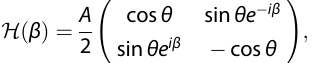
Fig. 2 Direct measurement of the QFI. a The pulse sequence for the measurement of the QFI using the NV center spin. The NV center spin is fi rst polarized in the state 0 j i by applying a green (532 nm) laser pulse and the θ -dependent resource state ψ subsequent microwave pulse Y θ . The interrogation (i.e., the free evolution) for time T results in the parameter-dependent fi nal state ψ θ ð β Þj i . The parametric modulation via the amplitude and phase-modulated microwave driving is described by the Hamiltonian H [ β ( t )] with β ð t Þ ¼ β þ a β cos ð ω t Þ . The spin-dependent fl uorescence after the inverse evolution, which rotates the state ψ monitors the coherent transition probability induced by the parametric modulation. b The parameter-modulation induced resonant transition measurement shows the probability that the NV center spin stays in the state ψ θ ð β Þj i as a function of the modulation frequency ω for a time τ = 450 ns. c The resonant coherent oscillation between the state ψ parameters in ( b ) and ( c ) are θ = π /3, A = (2 π )15.98 MHz, a β = 0.1 and ξ = (2 π )5.025 MHz. d The QFI measured in our experiment (red circle) is compared with the theoretical prediction (brown